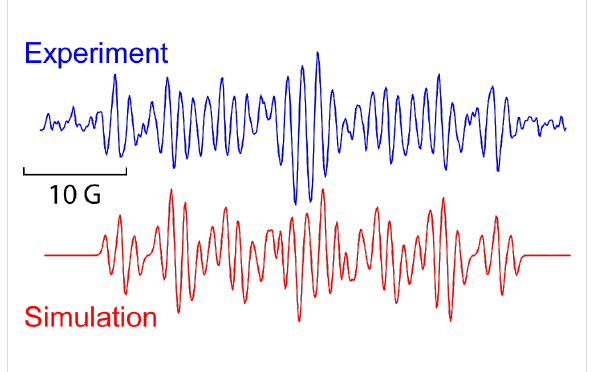
Figure 3: EPR spectrum during photolysis of 2a in t -BuPh at 230 K. Top (blue): experiment; bottom (red): simulation.